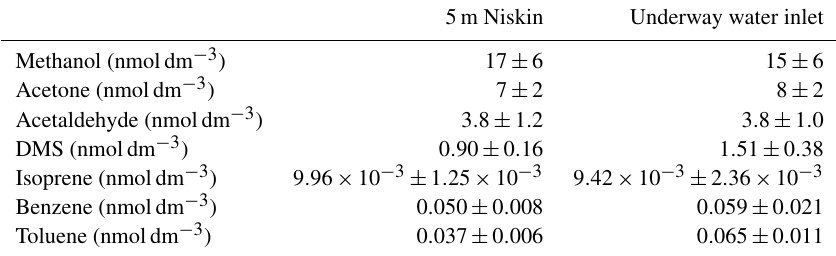
Table 3. Average concentration measured for each compound from the 5m Niskin bottle and 3h either side of the Niskin measurement from the ship’s built-in underway water inlet. Errors represent the 95% confidence interval of this average. 5m